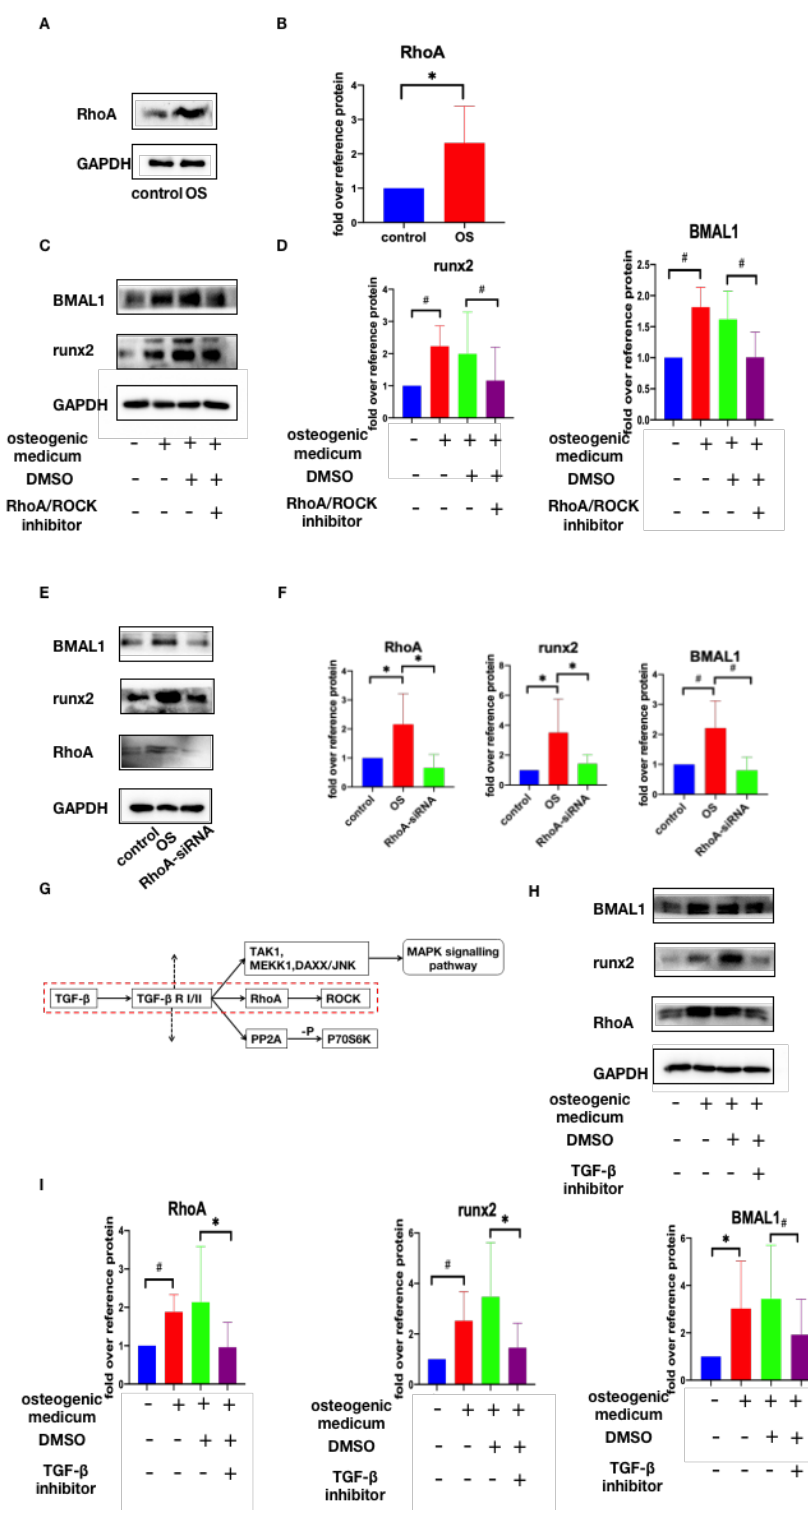
Figure 4. Osteogenic medium promotes BMAL1 expression through TGF- β /RhoA/ROCK path- way. ( A , B ) RhoA expression was increased in osteogenic medium, with n = 6 for each group. ( C – F ) RhoA/Rock inhibitor and RhoA-siRNA could both prevent osteogenic medium from pro- moting BMAL1 expression, with n = 6 for each group. ( G – I ) RhoA/ROCK was involved in TGF- β signaling pathway and TGF- β inhibitor could reduce RhoA and BMAL1 expression in osteogenic medium, with n = 6 for each group. * p < 0.05, # p < 0.01, OS, osteogenic